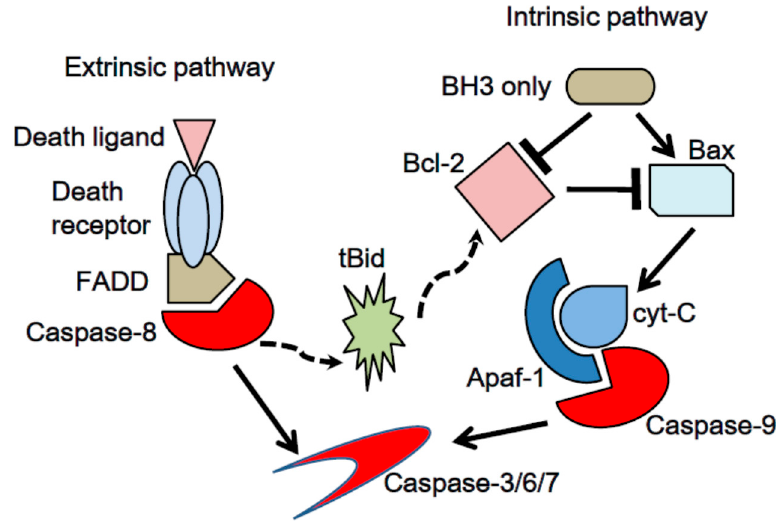
Figure 1. Two major pathways of apoptosis. Extrinsic pathway is induced by death ligand-death receptor interaction. Oligomerized death receptors form death inducing signaling complex (DISC). DISC activates initiator pro-caspase-8/10. Intrinsic pathway is initiated by Bcl-2 family members. Pro-apoptotic proteins, Bax and Bak, lead mitochondrial outer membrane permeability (MOMP), resulting leakage of cytochrome-c from mitochondrial inter membrane space into cytosol. Thus, cytochrome-c constructs apoptosome with Apaf-1 and activates initiator pro-caspase-9. Caspase-8 in extrinsic apoptotic cascades cleaves Bid into tBid, which recruits intrinsic apoptotic response.